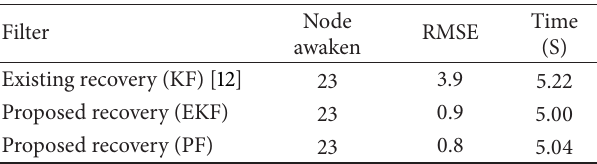
Table 3: Performance comparison: communication failure—Case